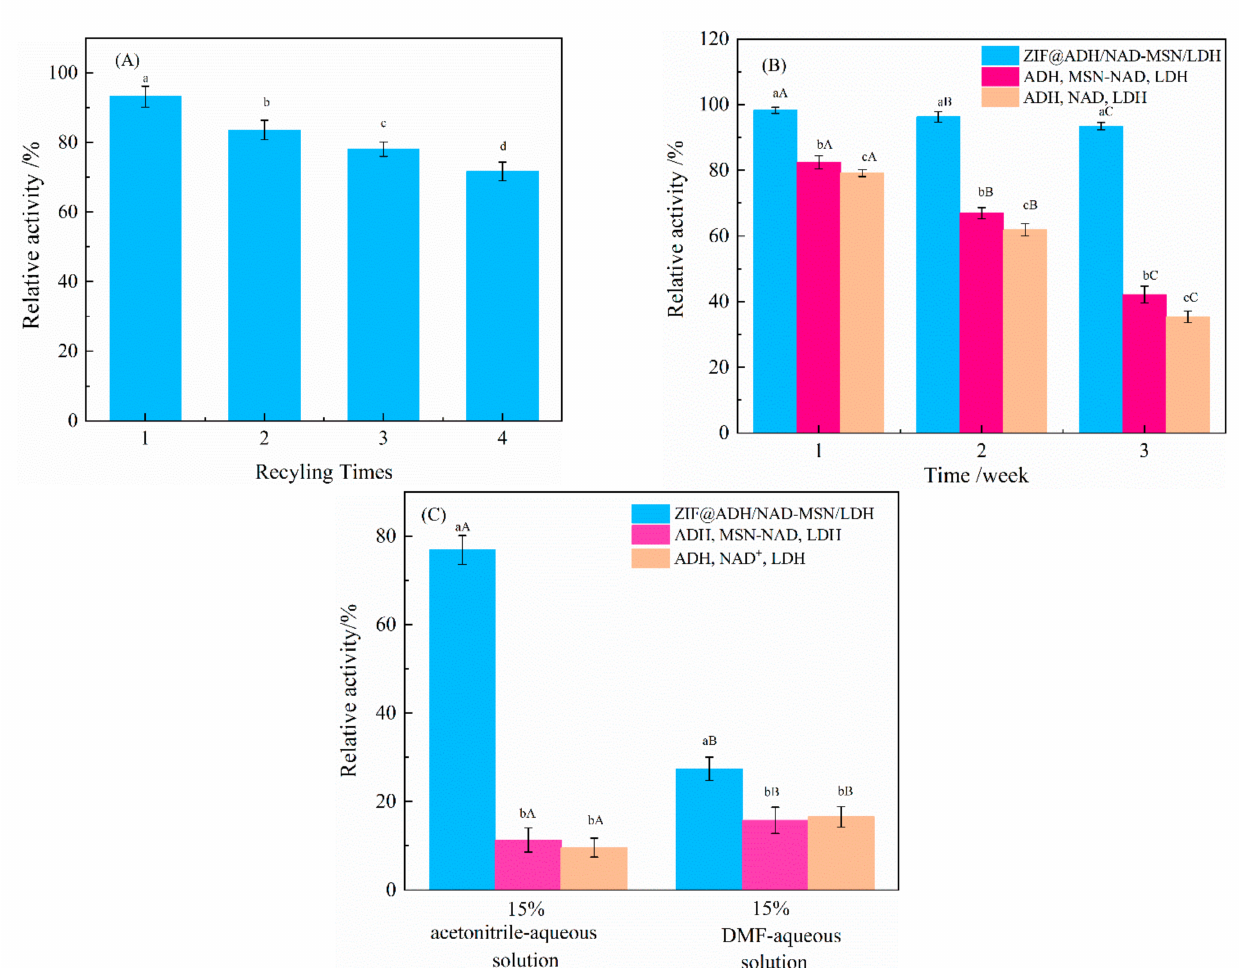
Figure 7. Reusability and stability. ADH: Alcohol dehydrogenase; LDH: Lactate dehydrogenase; NAD + : Nicotinamide adenine dinucleotide; ZIF@ADH/NAD-MSN/LDH: Core–shell nanocomposites prepared by ZIF-8 immobilized ADH, LDH and MSN-NAD; MSN-NAD: Mesoporous silica nanoparticles immobilized nicotinamide adenine dinucleotide. ( A ) The relative recovery rate of ZIF@ADH/NAD-polymer/LDH under different experiment times, ( B ) The relative activity of three experimental groups in PBS for three weeks at 4 ◦ C. The same lowercase letters mean that there was no significant difference in enzyme activity between different experimental groups at the same time. Different lowercase letters represented significant differences in enzyme activity in different experimental groups The same capital letter means that there was no significant difference in the enzyme activity of the same experimental group at different times. Different capital letters indicate that the enzyme activity of the same experimental group at different times was significantly different. ( C ) The relative activity of the three experimental groups after incubating in 15% acetonitrile and DMF solution for 1 h. The same lowercase letters represent that there was no significant difference in the enzyme activity of different experimental groups treated in the same organic solution for the same time. Different lowercase letters indicated that there were significant differences in the enzyme activity of different experimental groups treated in the same organic solution. The same capital letters indicate that there was no significant difference in the enzyme activity of the same experimental group after the treatment with the two organic solutions. Different capital letters indicate that the enzyme activity of the same experimental group after the treatment with two organic solutions was significantly different. The experimental results were repeated three